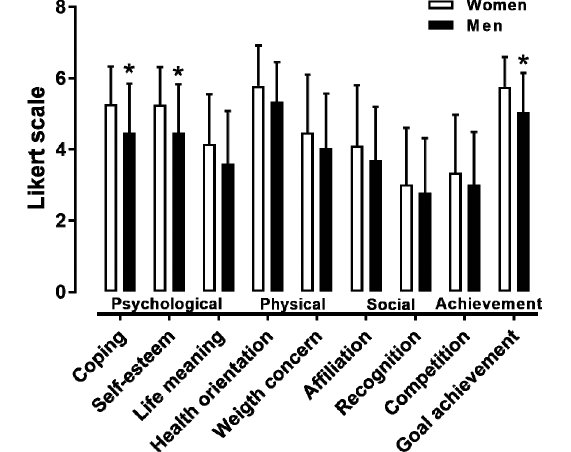
Figure 1. Nine MOMS-specific themes by sex. * p < 0.05. It should be noted that the Likert scale ranges from 1 to 7.